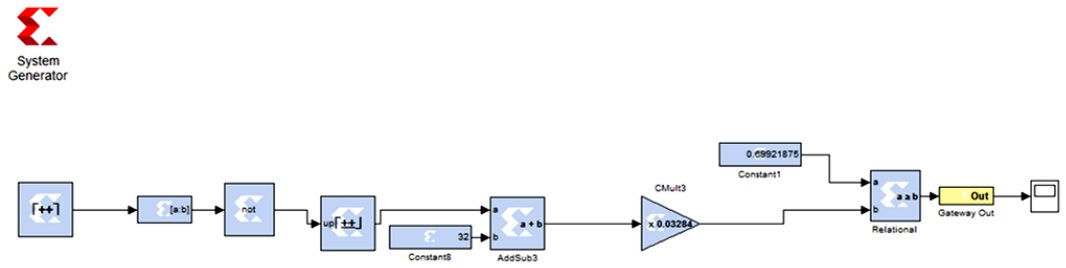
Figure 46. Control using FPGA.